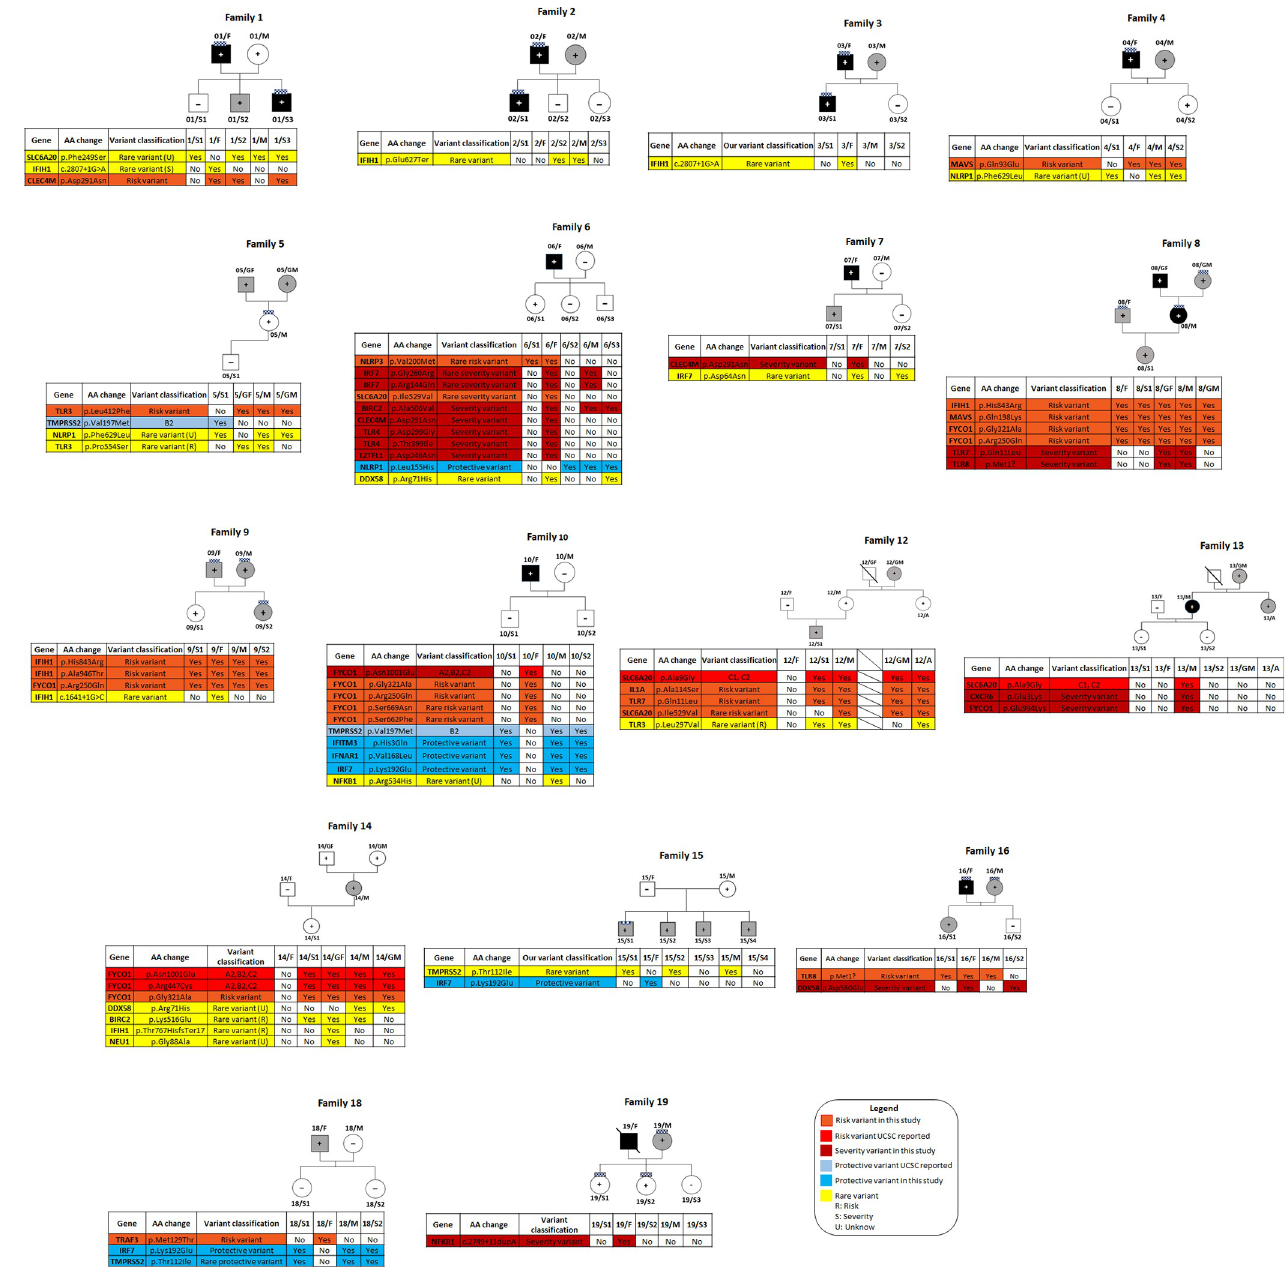
Fig 2. Significant genetic variants with respect to COVID-19 susceptibility and protection. Red: UCSC risk variants; light blue: UCSC protective variants; orange: our risk variants; blue: our protective variants; bordeaux: our severity variants; yellow: unknown correlation between rare variants and phenotype. https://doi.org/10.1371/journal.pone.0275988.g002 In six families (n˚1, n˚4, n˚5, n˚6, n˚16, n˚18), single risk variants segregated: the p. Asp291Asn in CLEC4M gene (MAF 26.5%), the p.Gln93Glu in MAVS gene (MAF 28%), the p. Leu412Phe in TLR3 gene (MAF 27,5), the p.Val200Met in NLRP3 gene (MAF 0,83%), the p. Met1? in TLR8 gene (MAF 30,5%), the p.Met129Thr in TRAF3 gene (MAF 32,8%), respectively.